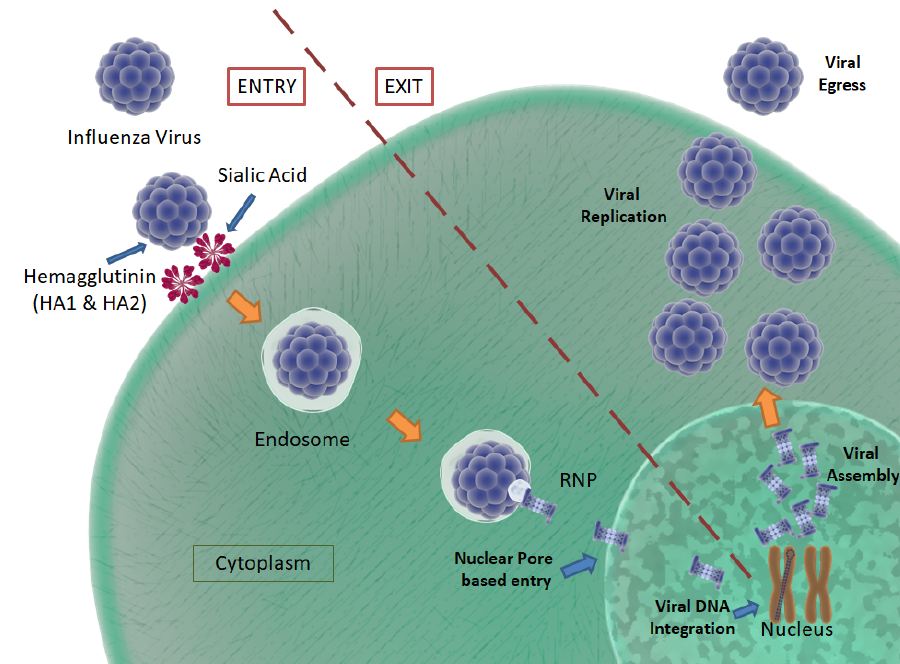
Figure 7. Influenza virus life cycle: Influenza virus entry, integration, assembly and egress, as pictured. The viral envelope is composed of HA and NA proteins. The HA proteins, HA1 and HA2, play a role in the fusion process of the virus T host cell. NA cleaves bonds between the host surface receptors and assists in viral egress. CC BY 4.0